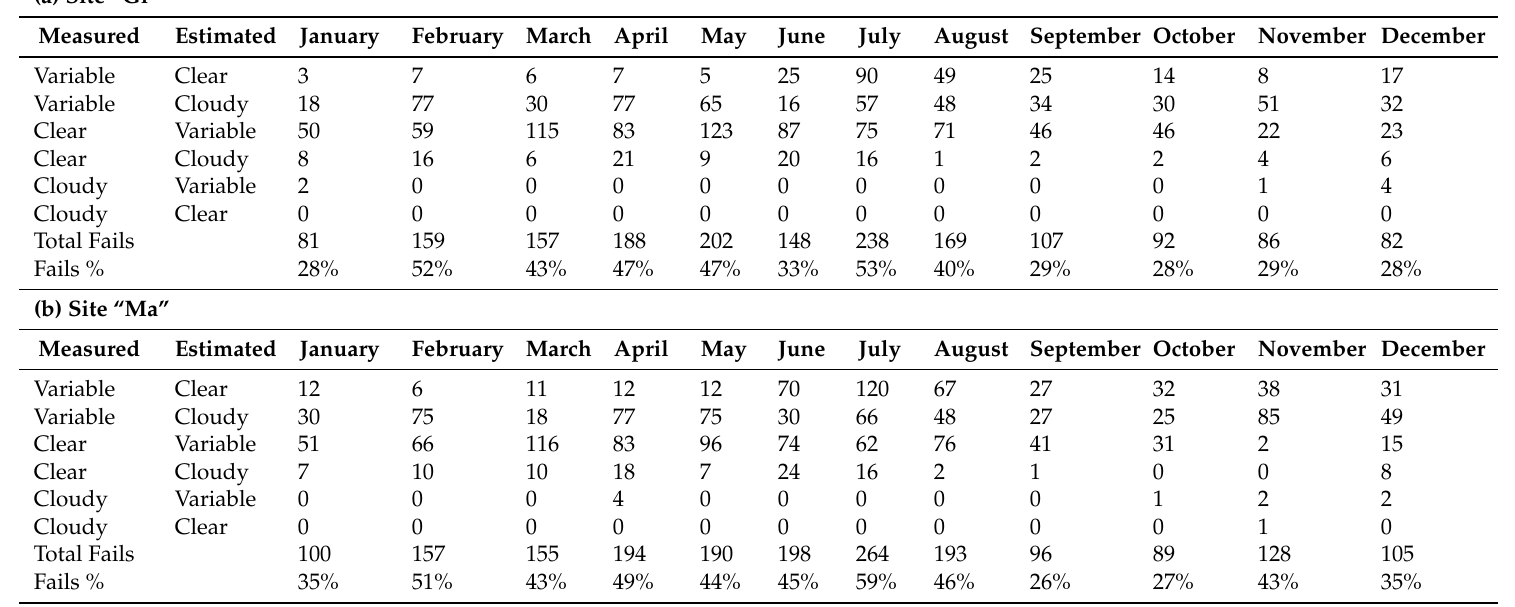
Table 3. Number of fails for all the months of